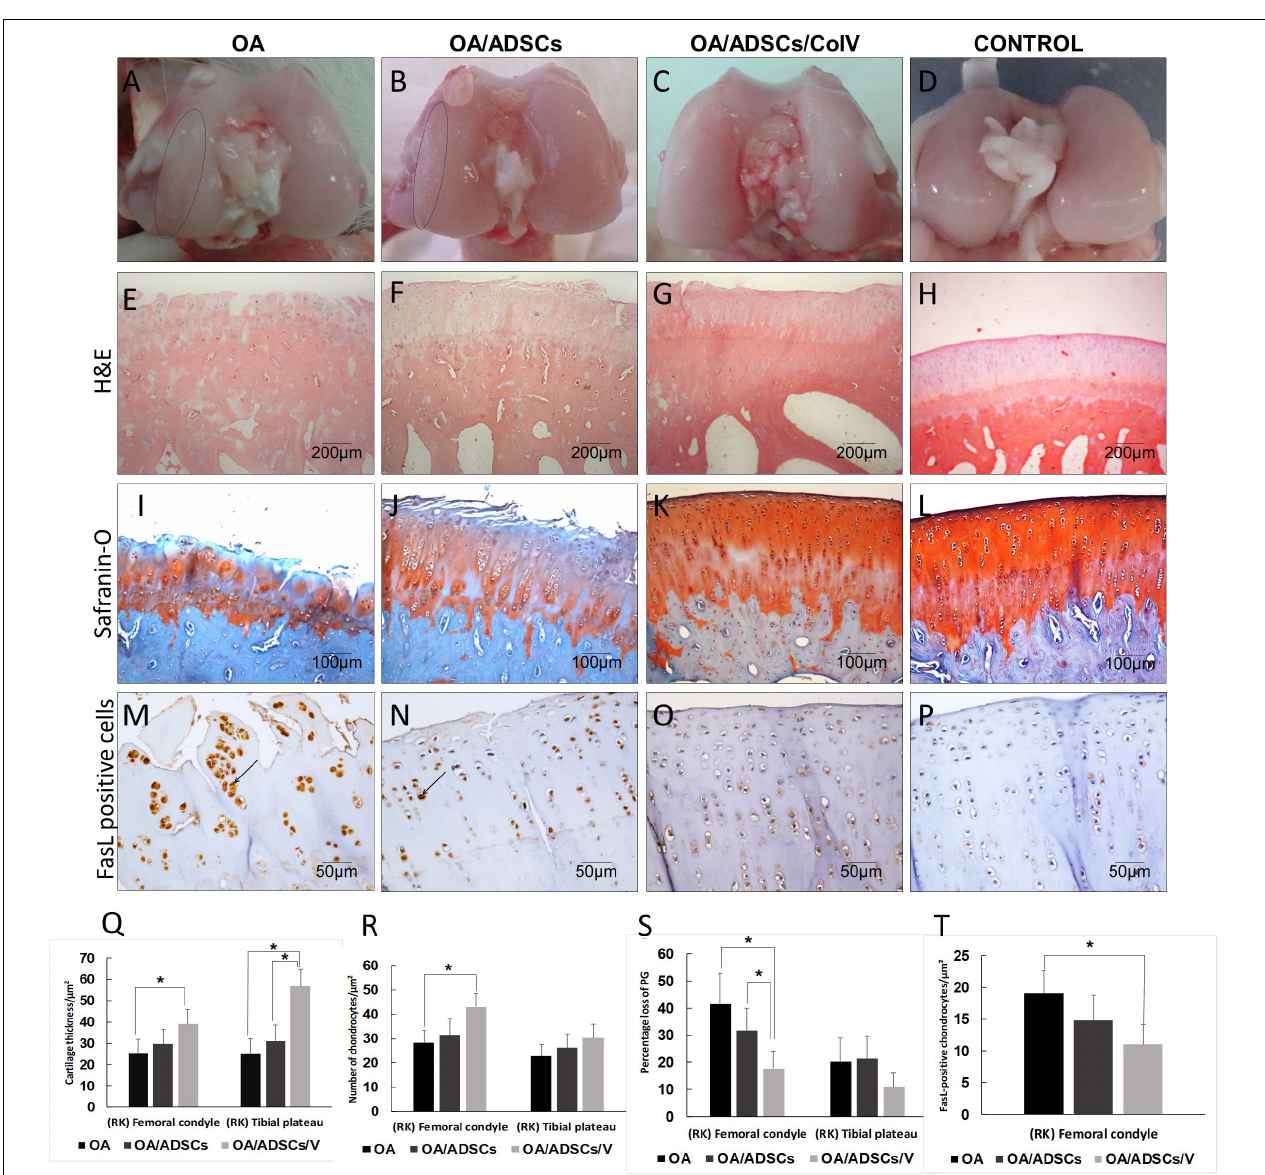
FIGURE 4 | The morphogenic changes showed typical signs of osteoarthritic rabbit articular cartilage regeneration post-ADSCs/Col V. (A–D) Coronal section of representative femoral heads. The circle indicates the femoral condyle cartilage degeneration. Hematoxylin and eosin (E–H) and Safranin O/Fast Green (I–L) staining. Chondrocytes apoptosis Fas ligand+(arrows) (M–P) . Morphometric analysis showing cartilage parameters of the upper outer subchondral bone of the femoral heads (Q) , chondrocytes (R) , proteoglycans (S) , and apoptosis (T) . * P < 0.05.